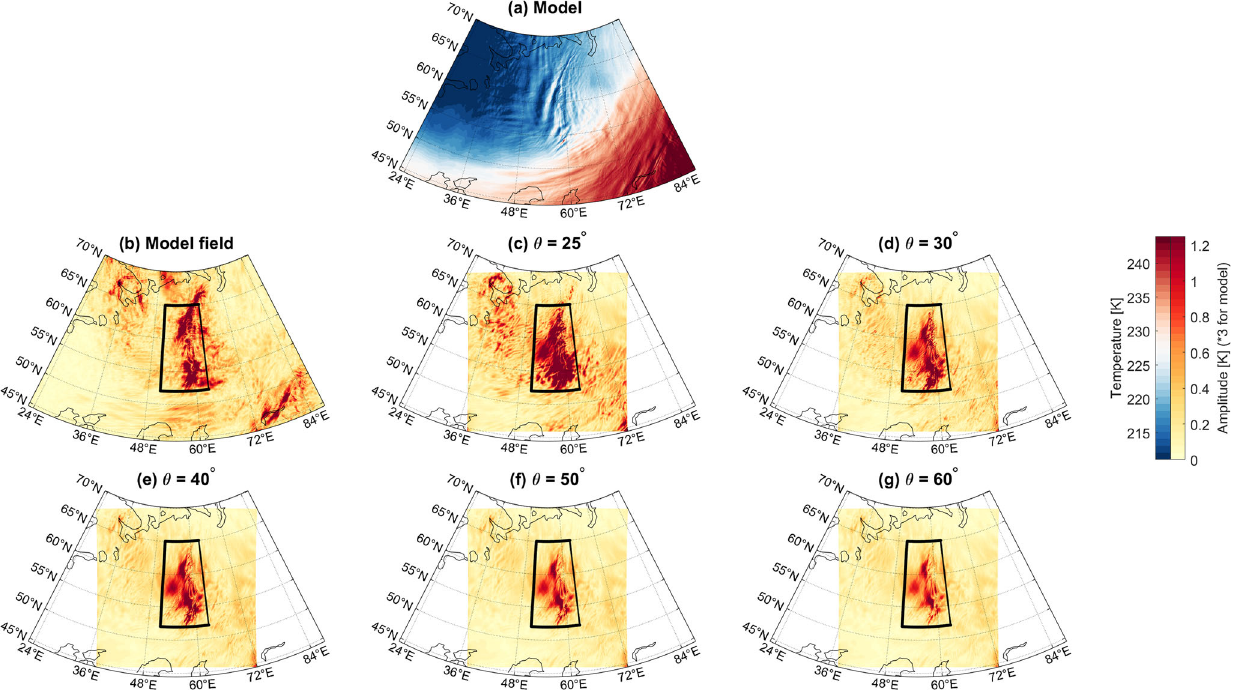
Fig. 3 Temperature amplitudes recovered for a sample orographic wave over the Urals. a Temperature output at 37 km altitude of the TCo7999 simulations. b – g Estimated amplitude of this wave as measured using a 2D Stockwell Transform method, for brightness temperatures computed from model output sampled across a range of viewing angles. Black boxes show region averaged over to generate Fig. 5. Note that amplitude values in panel ( b ) have been downscaled by a factor of 3 to aid visual comparison (see text for